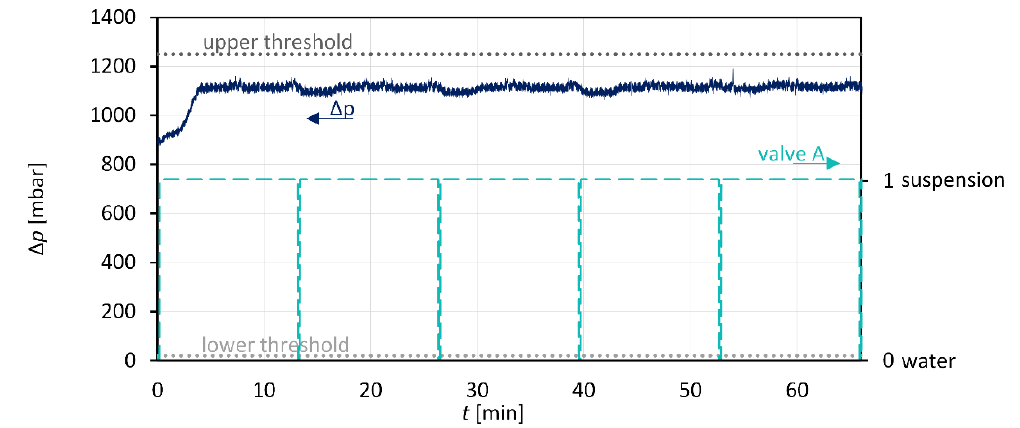
Figure 8. Pressure loss and magnetic valve position for “prophylactic rinse” (for experiment seed 90–125 2).